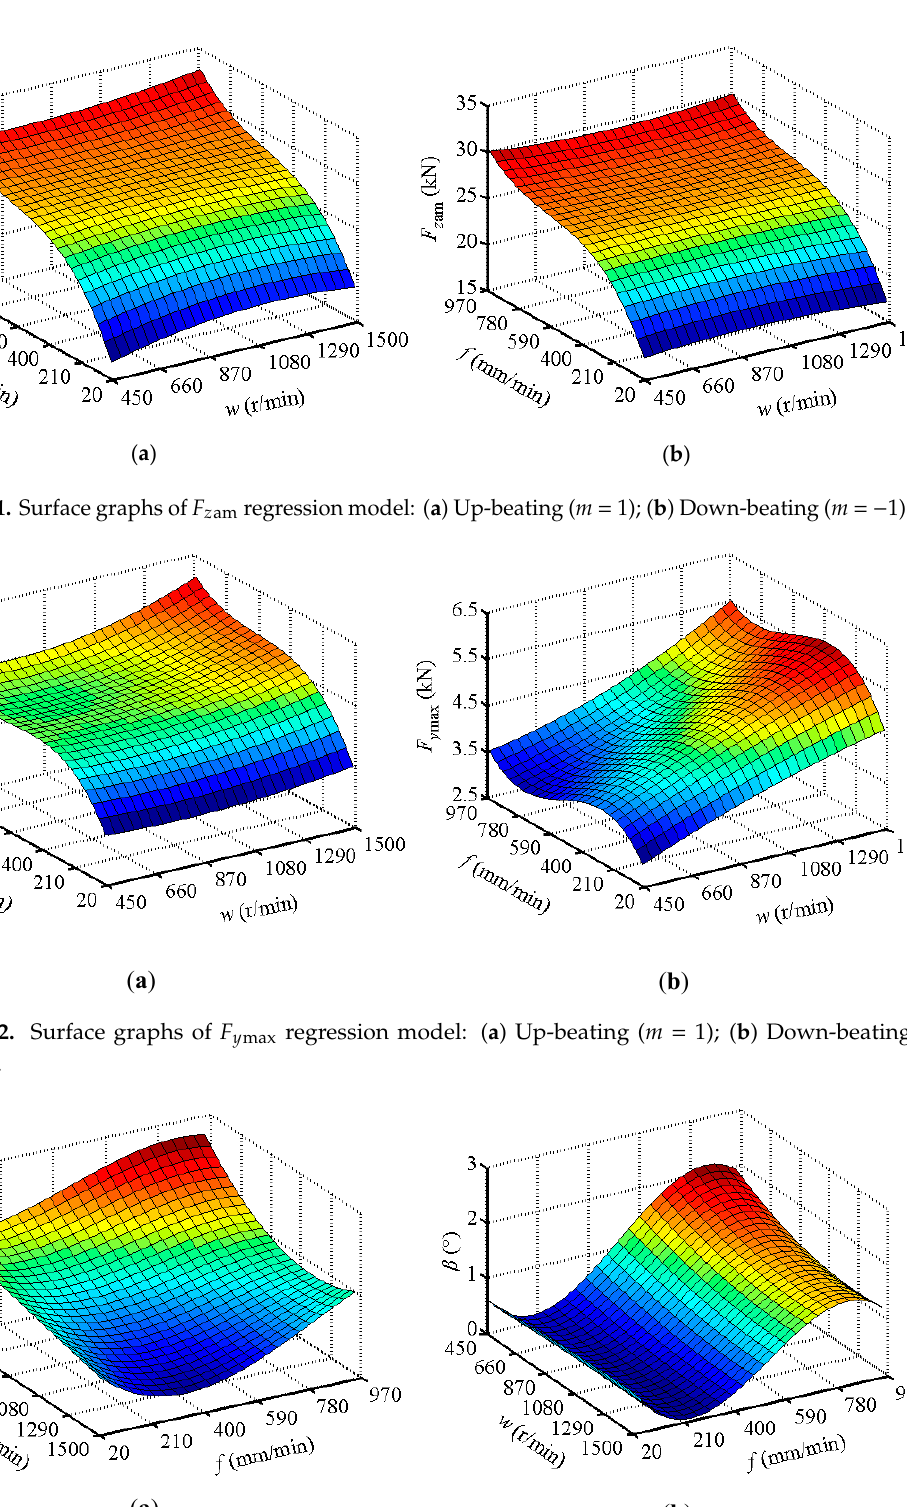
Figure 13. Surface graphs of β regression model: ( a ) Up-beating ( m = 1); ( b ) Down-beating ( m = –1).